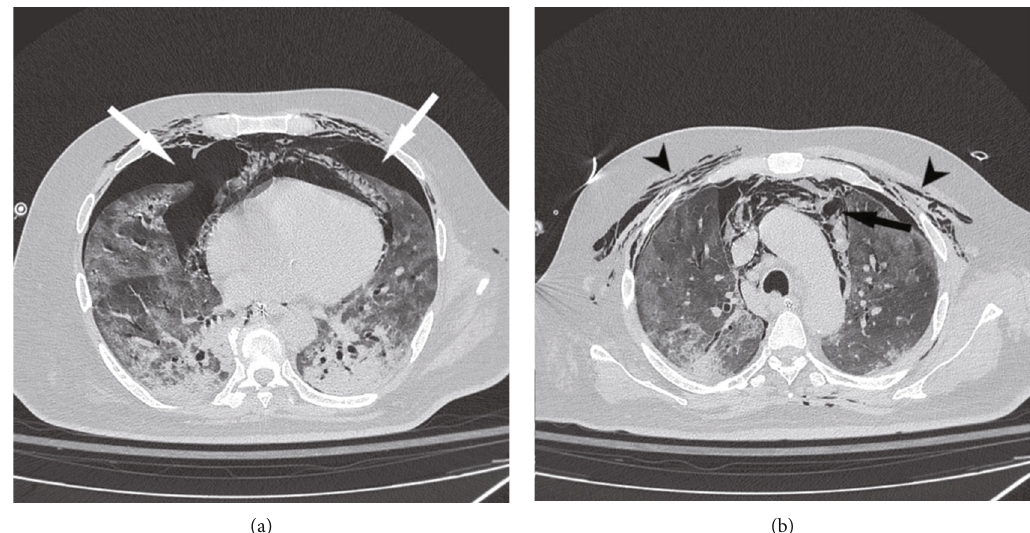
Figure 1: Chest CT. A chest CT scan shows bilateral pneumothorax (white arrows) (a), subcutaneous cervical and thoracic emphysema (arrowheads), and pneumomediastinum (black arrow) (b). Bilateral, patchy ground-glass opacities consistent with interstitial pneumonia are also shown.